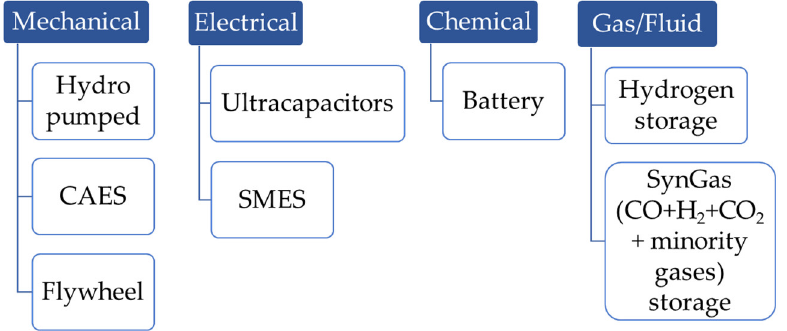
Figure 2. Energy Storage Technologies: Classification according to nature of technology. CAES: Compressed Air Energy Storage. SMES: Superconducting Magnetic Energy Storage.